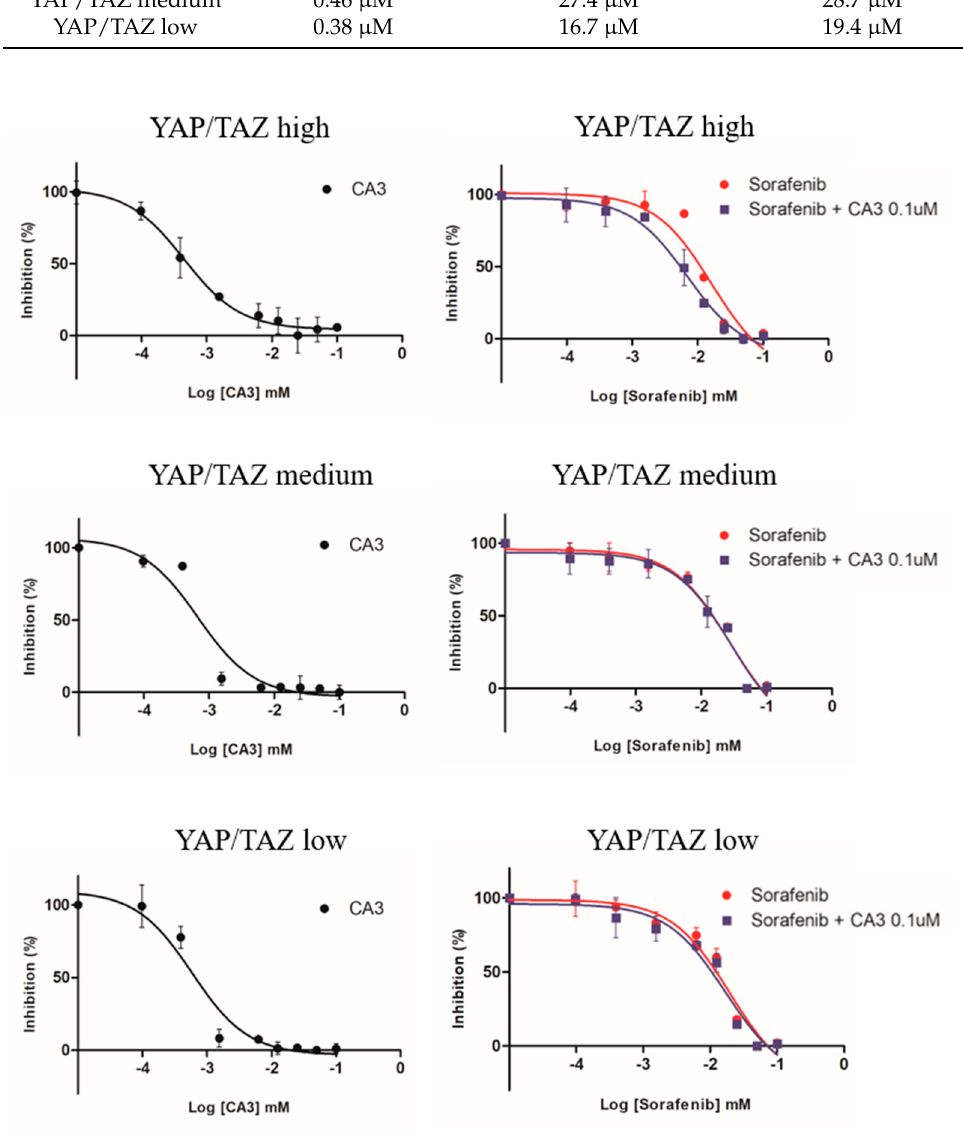
Figure 8. Comparative dose response curves using MCTS. MCTS were treated with CA3 at the indicated concentrations for 48 h. The dose response curve of CA3 monotherapy was presented as black full circles. MCTS were treated with sorafenib alone or sorafenib combined with CA3 0.1 µ M at the indicated concentrations for 48 h. Dose response curves of sorafenib (red full circles) and sorafenib combined with CA3 0.1 µ M (blue full squares) are